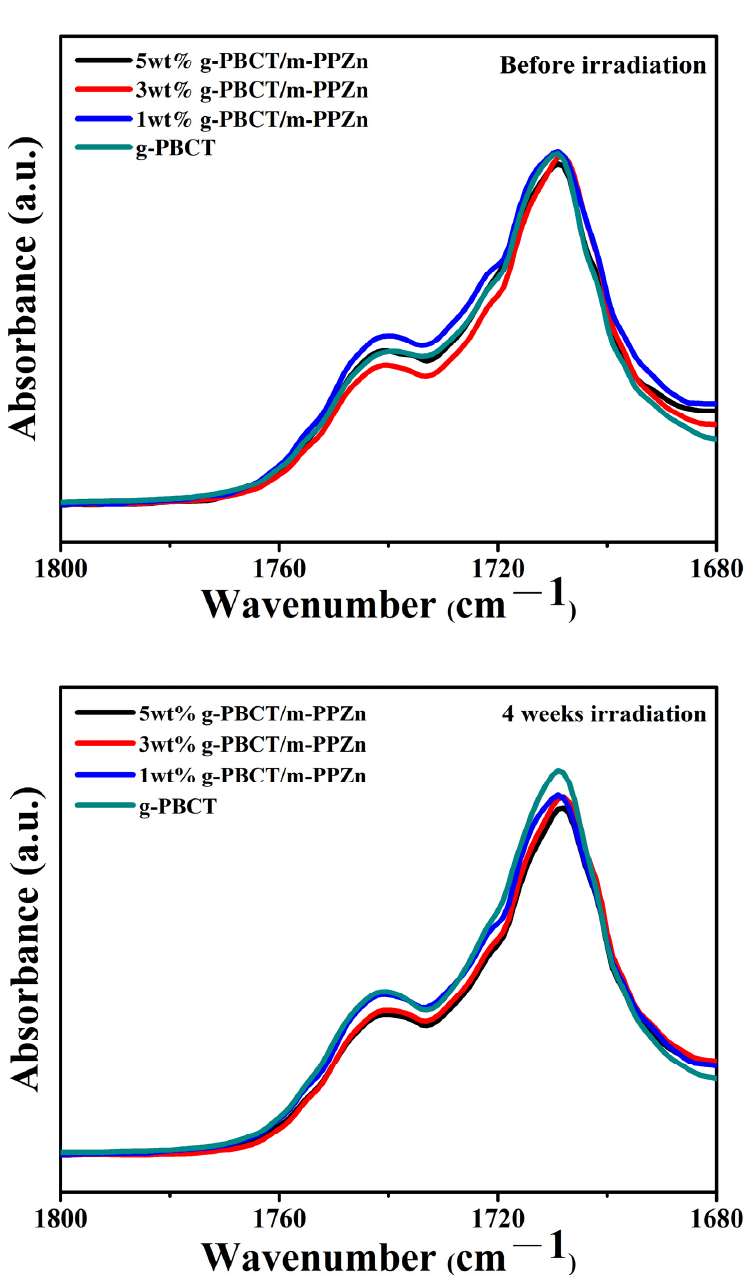
Figure 7. Change of FTIR spectra of g-PBCT and various weight ratios of g-PBCT/m-PPZn composites before and after 4 weeks UV irradiation times.